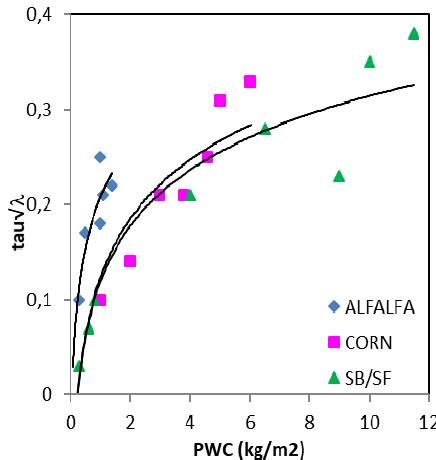
√ λ and PWC for some crop types: alfalfa, corn, sugar-beet (SB) and Figure 9. Relationship between τ Figure 9. Relationship between  √  and PWC for some crop types: alfalfa, corn, sugar-beet (SB) and sunflower sunflower (SF)